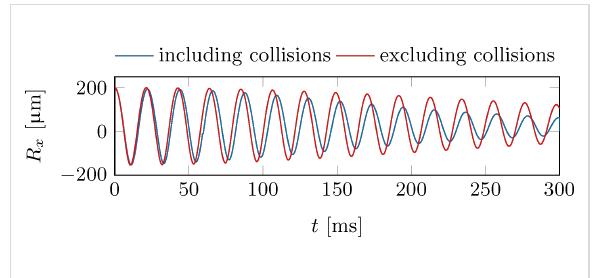
Figure 3: Center-of-mass oscillation of a cold-atom tip in an anhar- monic potential with/without particle collisions (blue/red solid line). The simulation parameters have been chosen as before: T = 500 nK, N = 5 × 10 5 atoms, ε = 2 × 10 8 m − 1 s − 2 , ( ω x , ω y , ω z ) = 2 π × (50, 500, 500) Hz, A = 200 μ